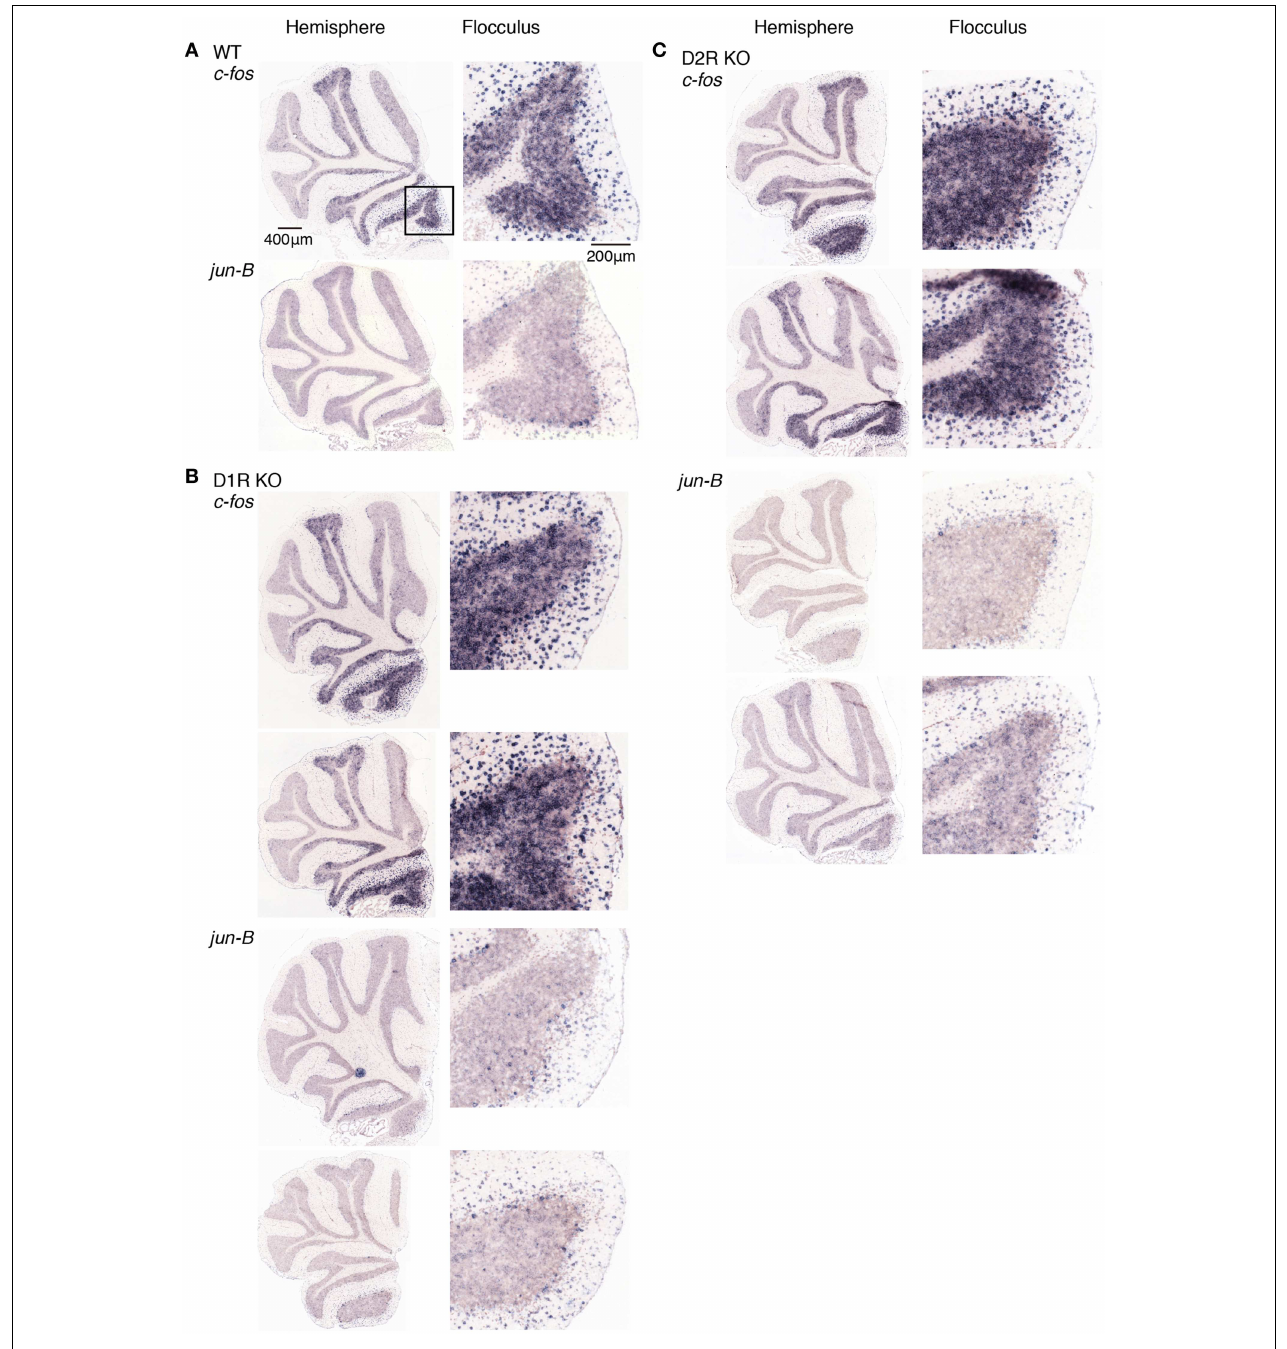
show magnified images of the flocculus enclosed in a box in the top image of the left panel, which shows the flocculus. (B) D1R KO and (C) D2R KO mice. Top row shows the sections from mice under fast-slow (15–5rpm) conditions during the training sessions, and the second row shows the sections from mice under slow-fast (5–15rpm) conditions (see Materials and Methods for